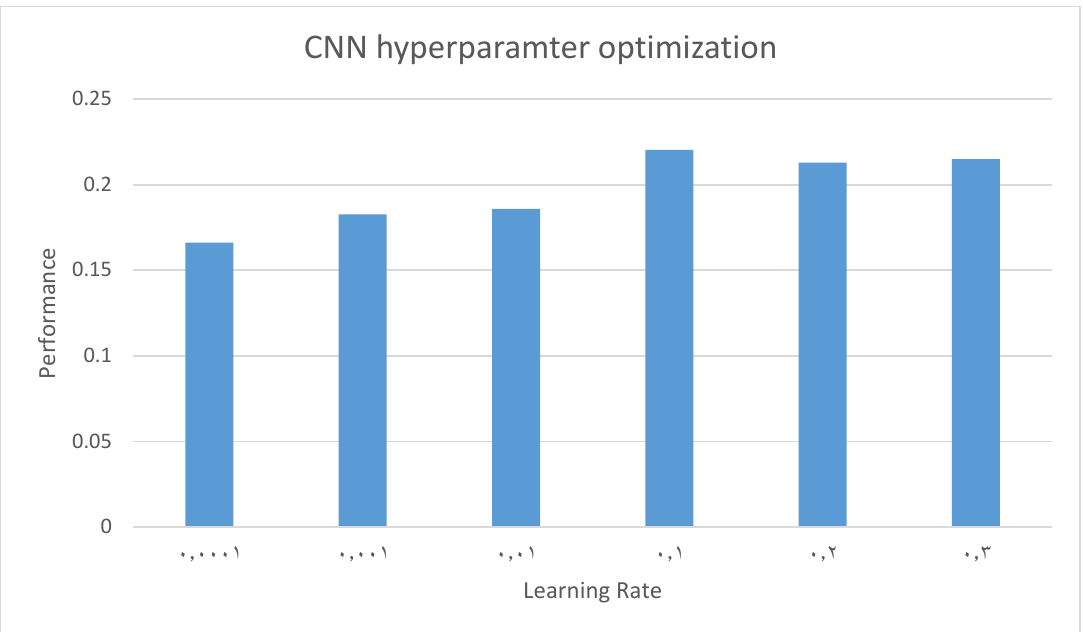
Figure A-7 Optimized Learning Rate of CNN